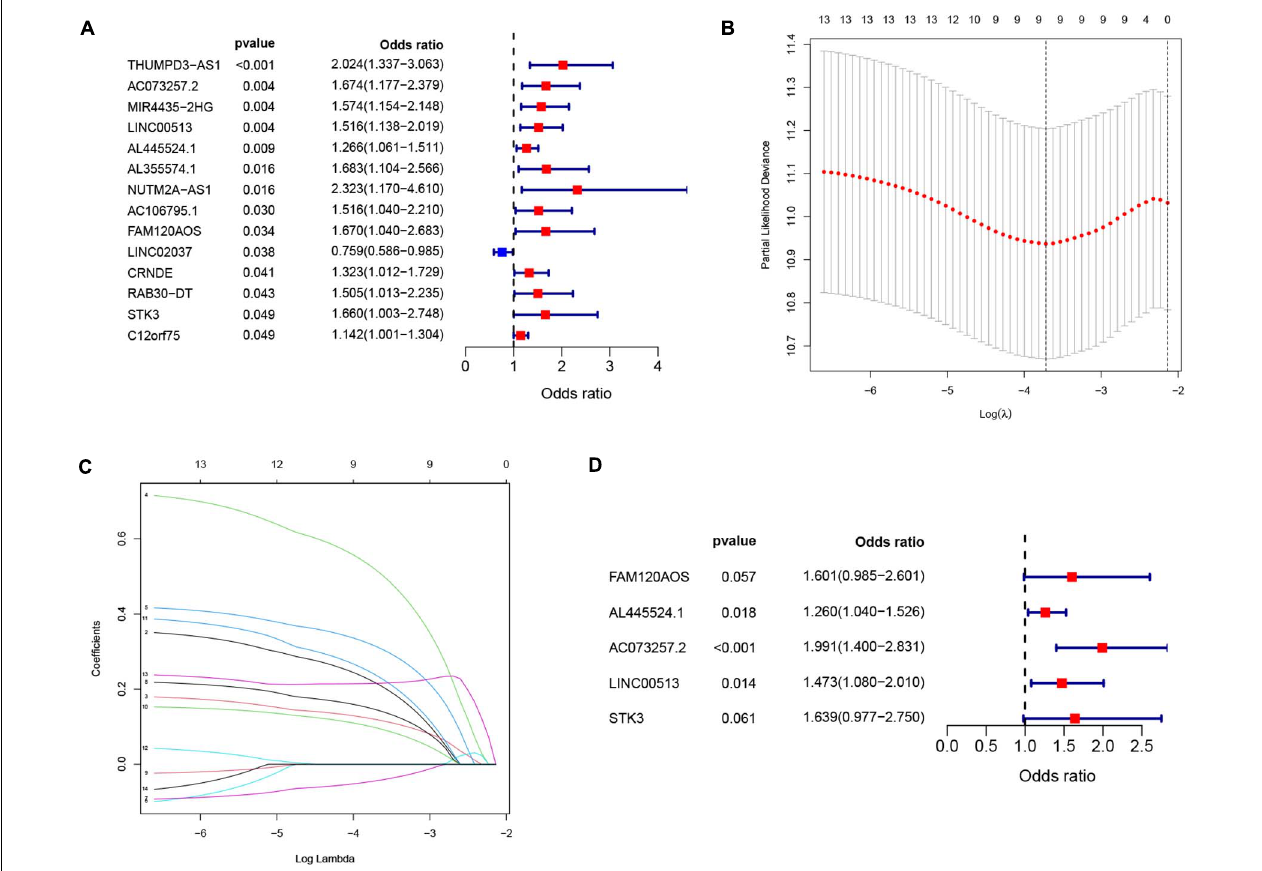
FIGURE 1 | Identification of immune-related eRNAs from hepatocellular carcinoma. (A) Univariate Cox regression models identified 14 immune-related eRNAs that are associated with OS. Two analyses (B,C) by a lasso regression further fine-tuned the selection of immune-related eRNAs. (D) Multivariate Cox regression analysis identified five immune-related eRNAs for the construction of a prognostic